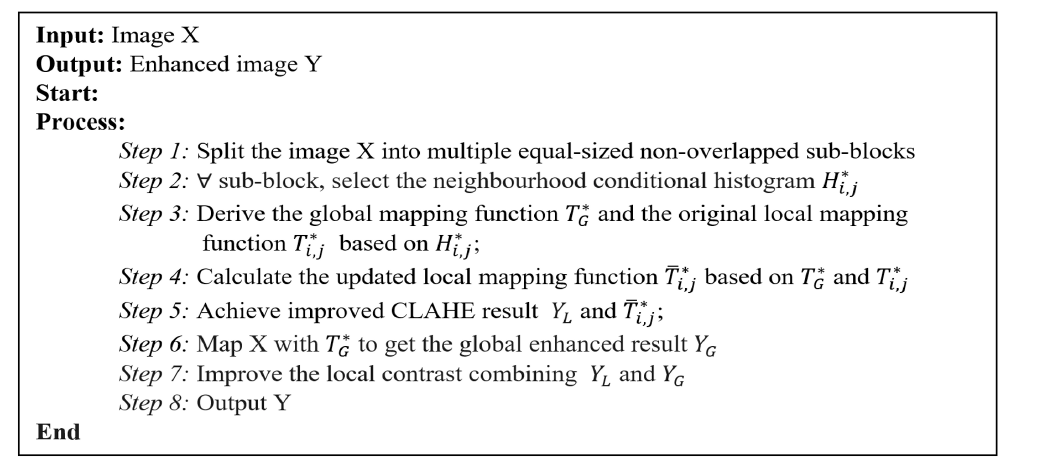
Figure 3. Algorithm of image enhancement.